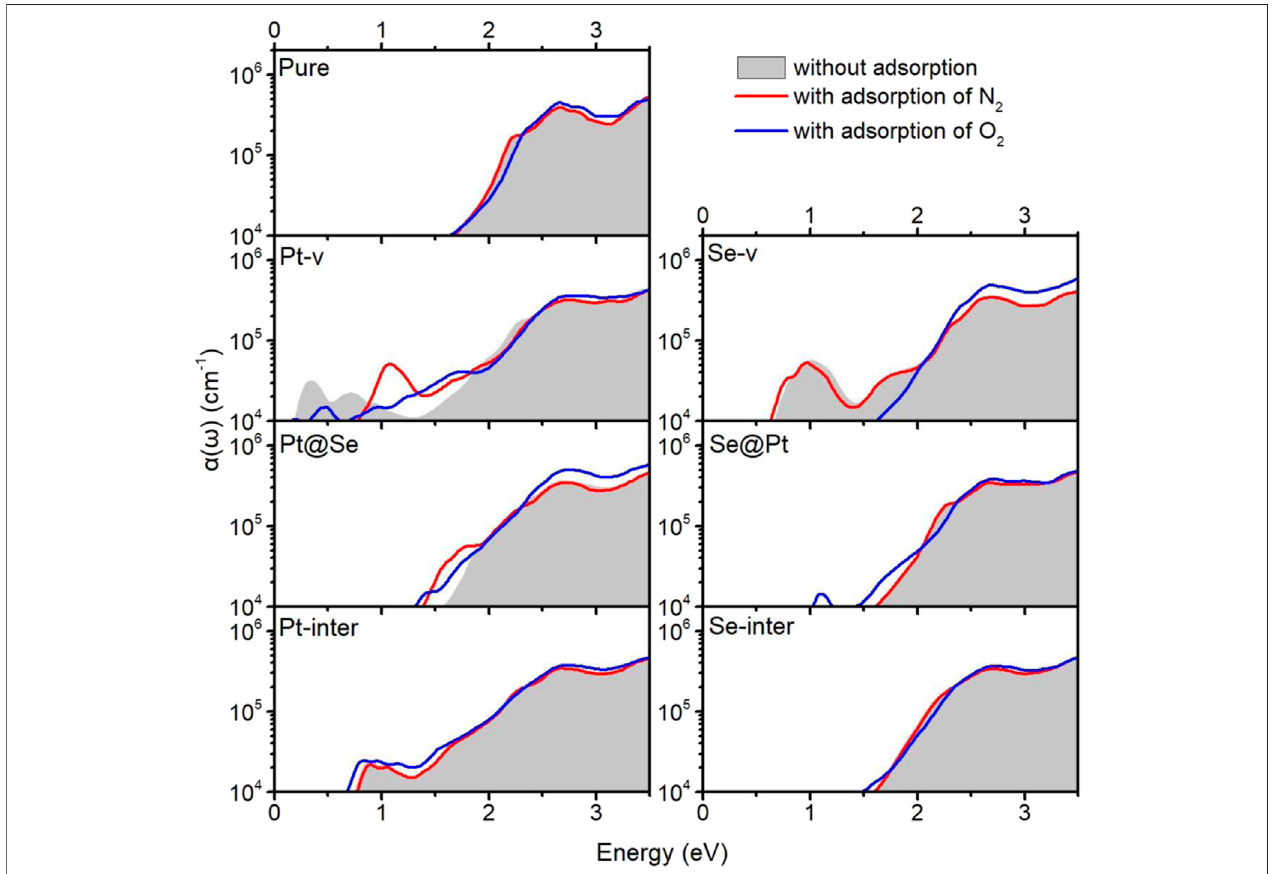
FIGURE 5 | Optical absorption coef fi cients α ( ω ) of pure PtSe 2 and defected PtSe 2 with adsorption of N 2 (red line) and O 2 (blue line). The gray areas indicate the optical absorption coef fi cients of pure PtSe 2 and defected PtSe 2 .